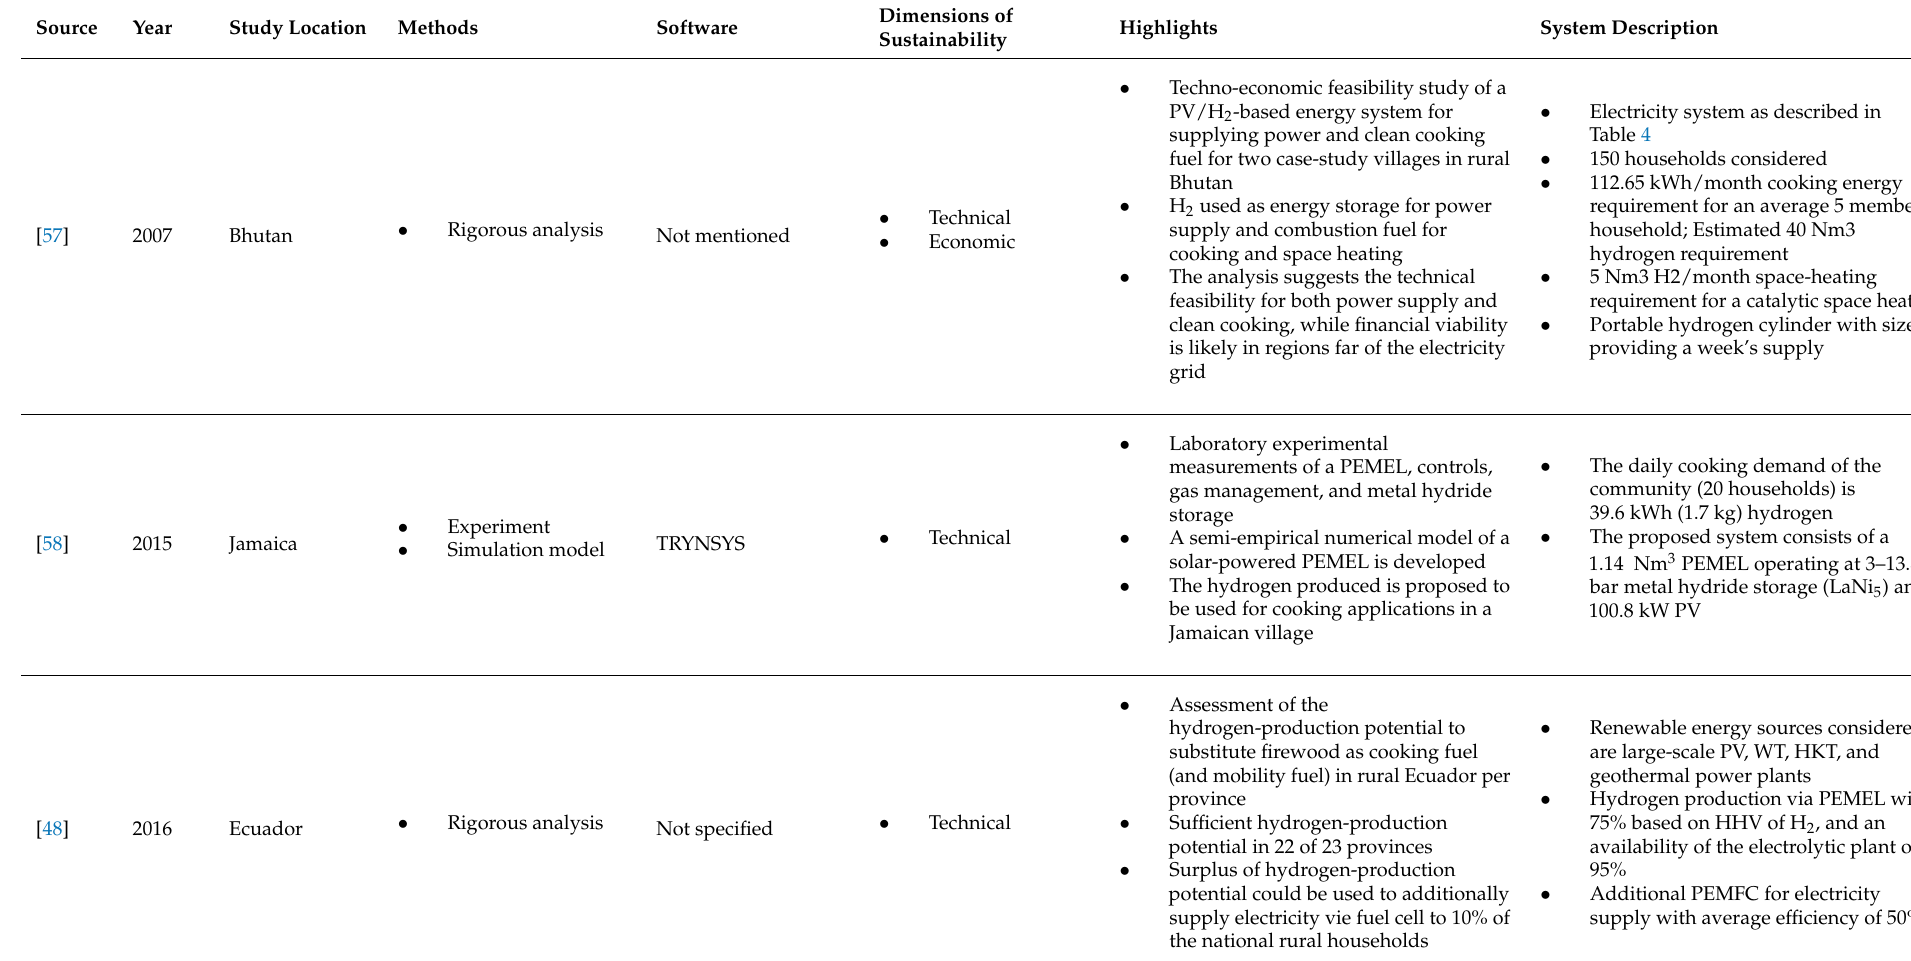
Table 7. Variables of interest for literature considering separate power supply and hydrogen utilization as clean cooking fuel via